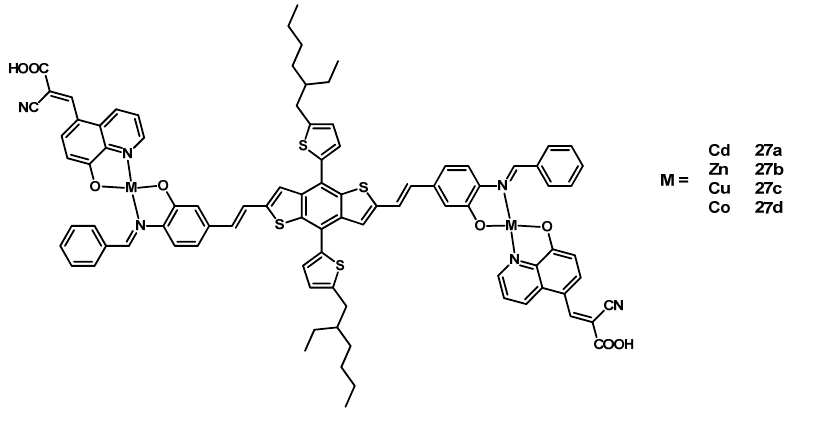
Figure 12. Structure of dyes 27a – d .